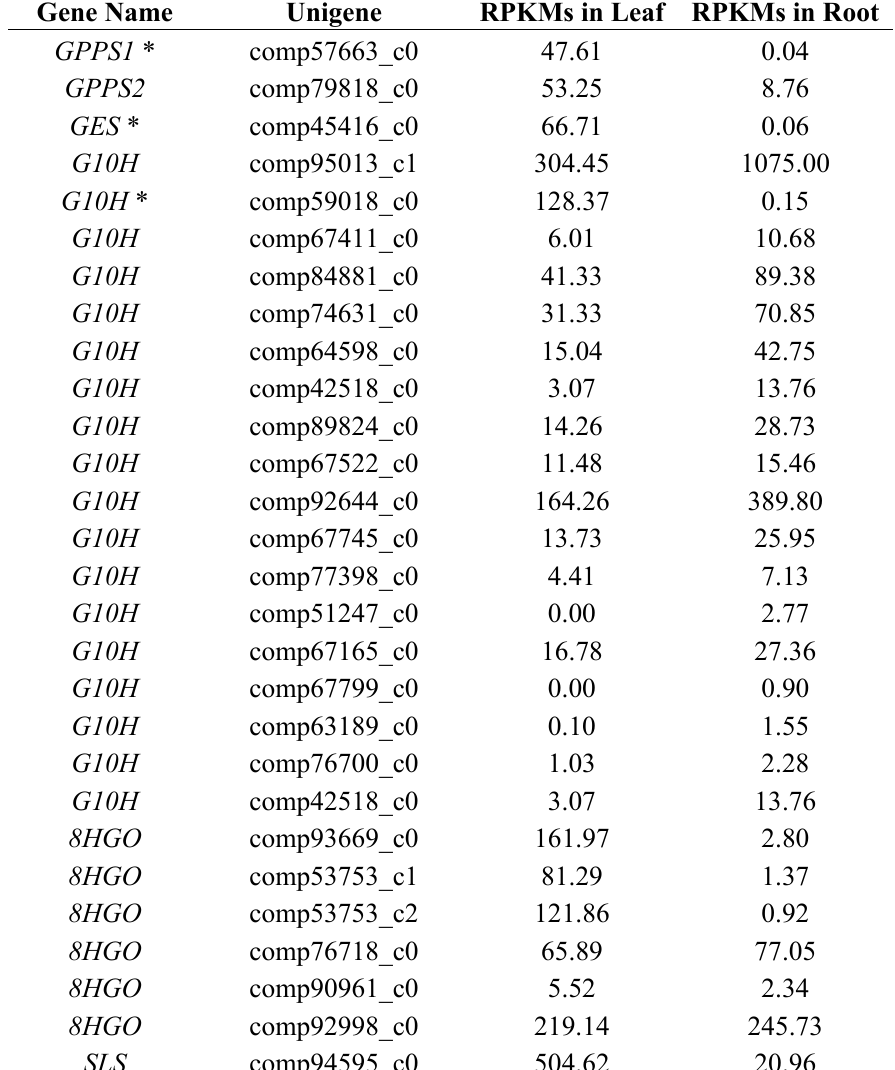
Table 5. Expression of putative genes in secoiridoid biosynthesis